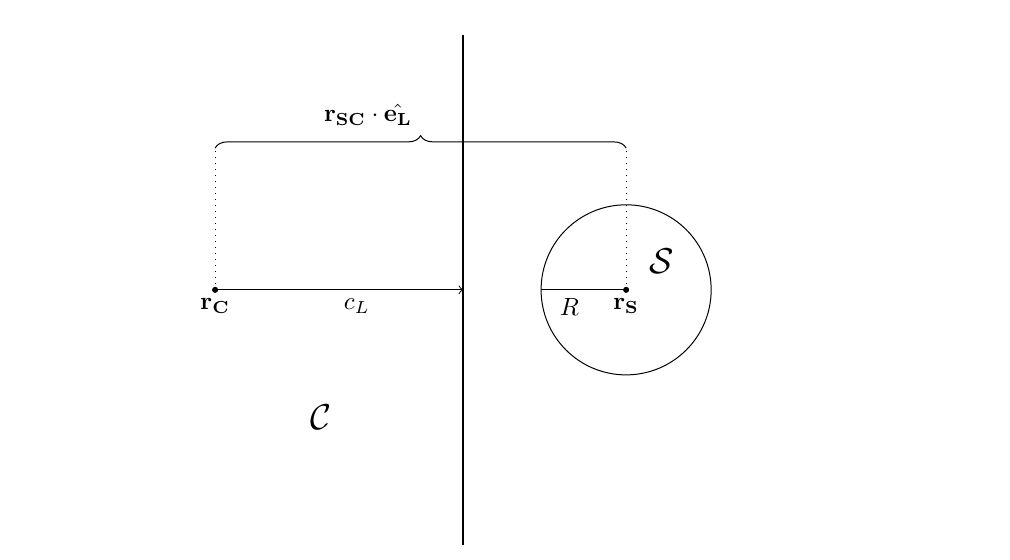
ˆ e L . Sphere · ˆ e L > ·